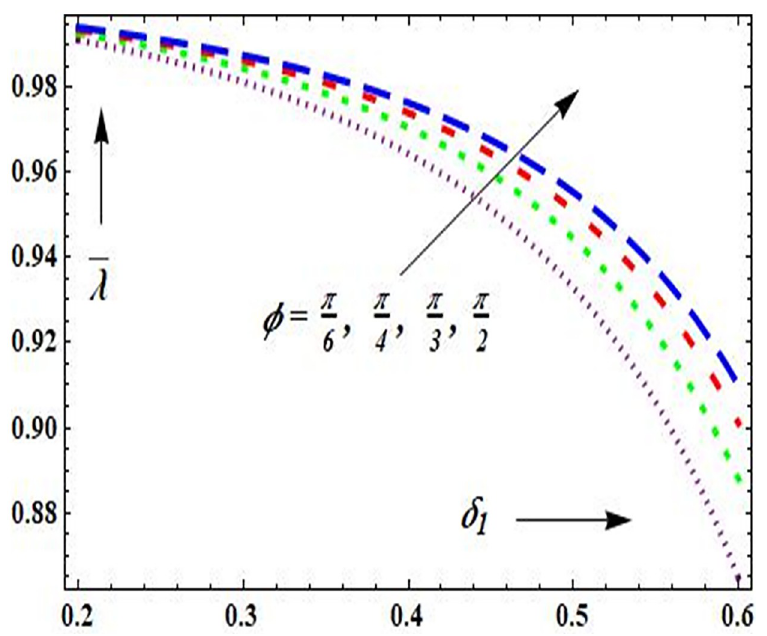
Fig 6. Plot of � λ on ϕ & δ 1 with r = 0.2, d 1 = 0.2, F = 0.3, d 2 = 0.6, L 2 = L 1 = 0.2, M = 2.0, Q = 0.1.